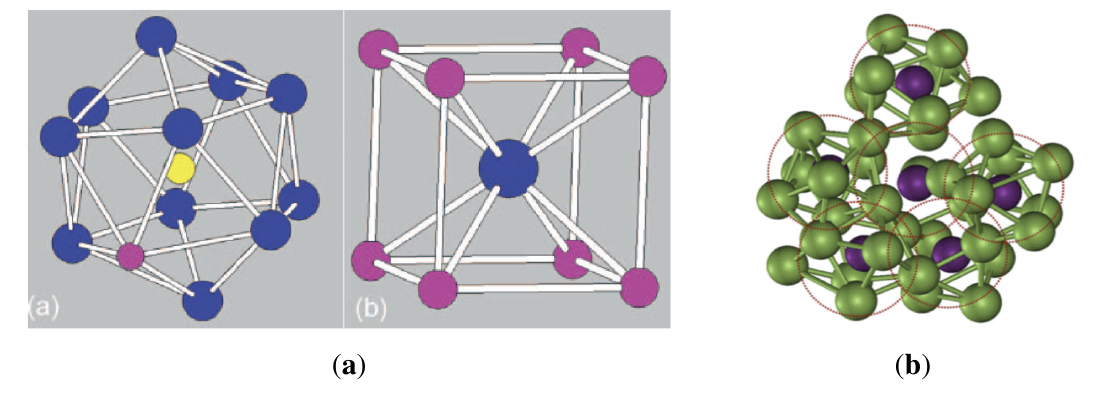
Figure 18. Another model of amorphous structure based on packing regular cubic and icosahedral